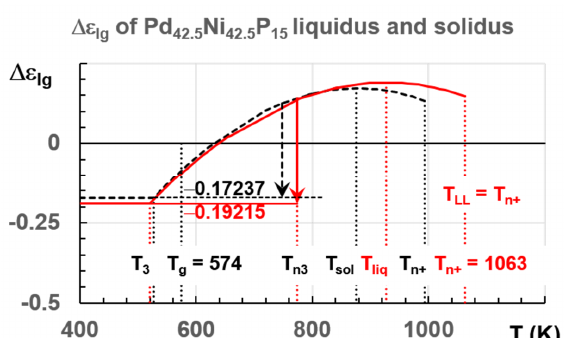
Figure 16. Enthalpy coefficients of liquidus and solidus melts versus T (K). T liq = 926.5 K, T n+ = 1063 K, T sol = 876 K, and its T n+ = 993 K. Crystallization at the nucleation temperature T 3 = 748.4 K of phase 3 in solidus melt instead of T 3 = 774.2 K in liquidus melt. In the liquidus melt, T LL = T n+ = 1063 K.